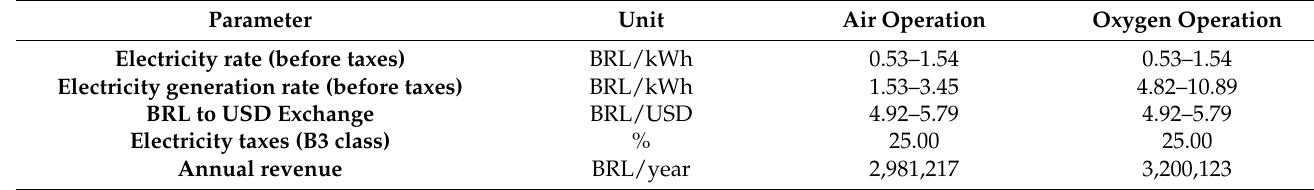
Table 10. Annual revenue from the power system.